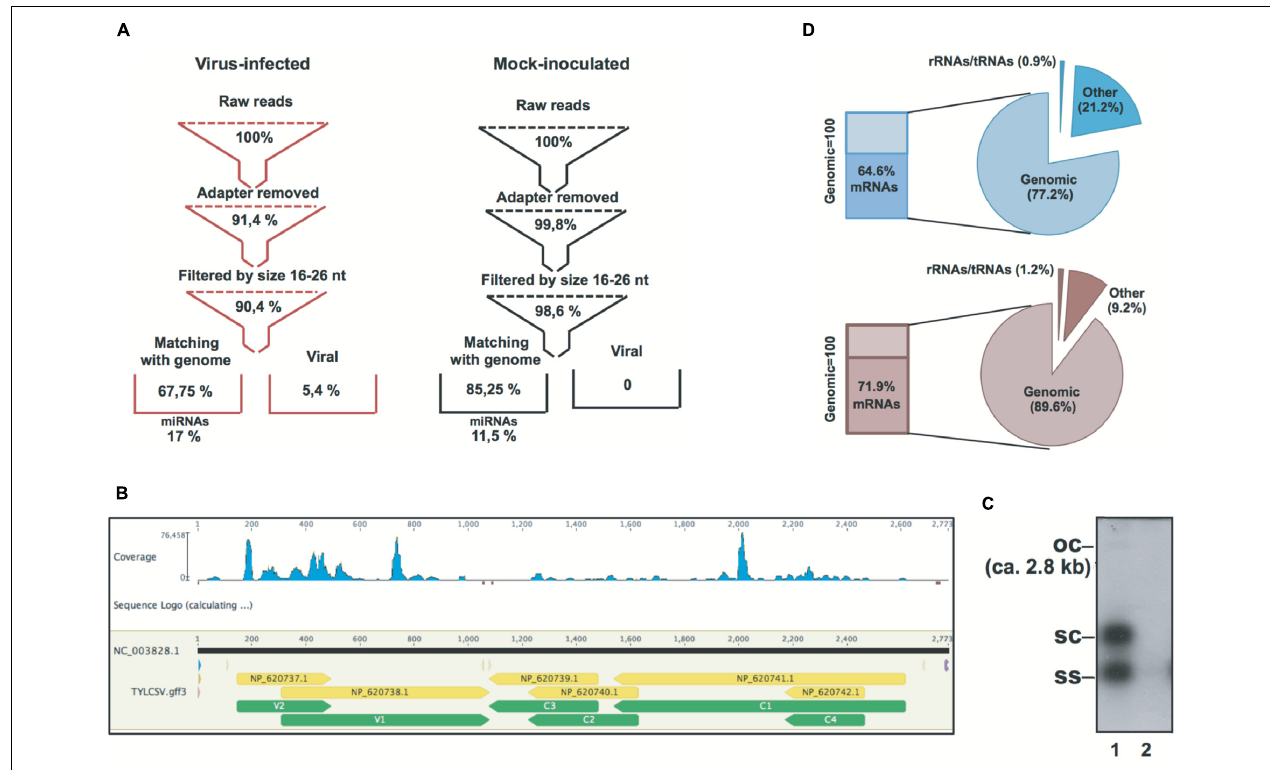
FIGURE 1 | Statistics of Solanum lycopersicum genomic and non-genomic siRNAs in TYLCSV-infected and mock-inoculated plants. (A) Flowchart of sRNA datasets from raw data to genomic miRNAs and non-genomic viral sRNAs in virus-infected and mock-inoculated plants, respectively. (B) Distribution of TYLCSV-derived siRNAs in virus-infected plants. (C) Southern blot analysis of DNA from TYLCSV-infected tomato leaf tissue (lane 1) or from mock-inoculated tomato leaf tissue (lane 2). oc = open circle; sc = supercoiled; ss = single stranded. (D) Composition of PARE datasets in mock-inoculated and virus-infected plant tissues in terms of alignment or reads with rRNA, tRNAs, tomato genomic sequence, and tomato transcriptome (indicated in the figure as “mRNAs”).